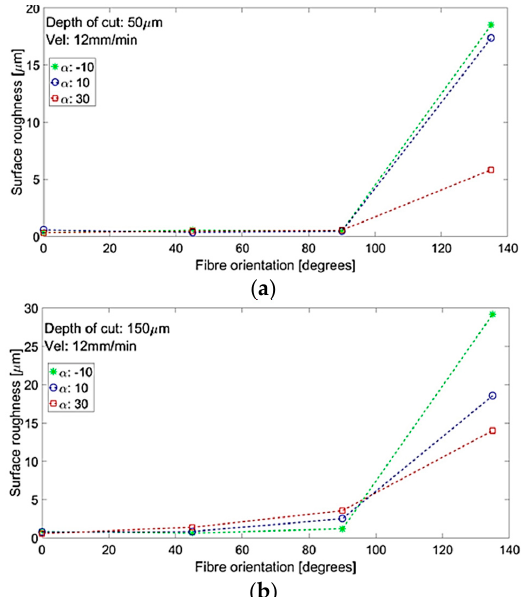
Figure 20. The combined effect on surface roughness ( R a ) of ( a ) depth of cut and fibre orientation at constant α : 10°; V c : 57 mm/min; and ( b ) fibre orientation and tool rake angle at constant DOC: 100 µm; V c : 570 mm/min.